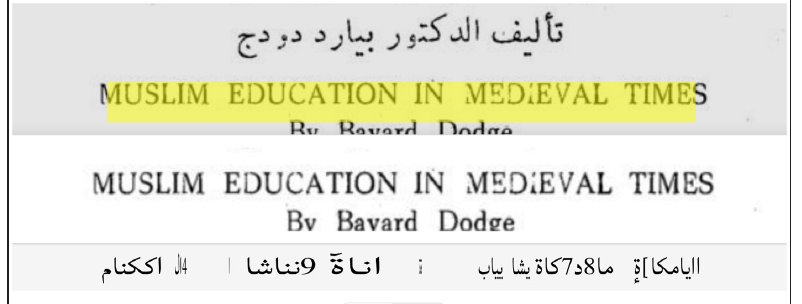
Figure 25: Example of particularly poor transcription of non-Arabic language in a page of primarily Arabic